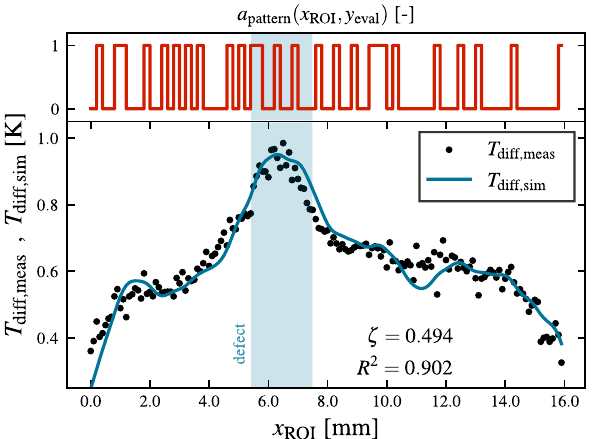
Figure 3. Quality of the forward solution and estimation of ζ : Synthetic measurement data T diff,sim (blue line) generated for a ROI featuring a 2 mm wide defect 0.5 mm below the surface (see Fig. 6) and an illumination pattern with β = 0.5 and d spix = 0.2 mm is shown next to measured data T diff,meas (black dots) using the same illumination pattern over the same ROI. The defect contrast factor ζ = 0.494 has been determined as best-fit. The measured data and the synthetic data lie in good agreement ( R 2 = 0.902 ).